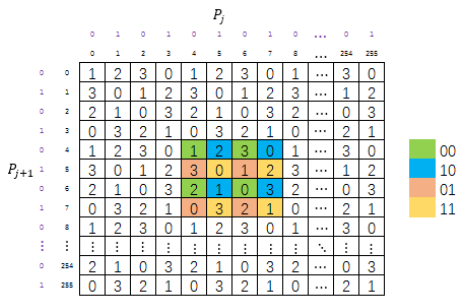
Figure 5. Candidates of embedding for di ff erent combinations of B 2 and B 3 .